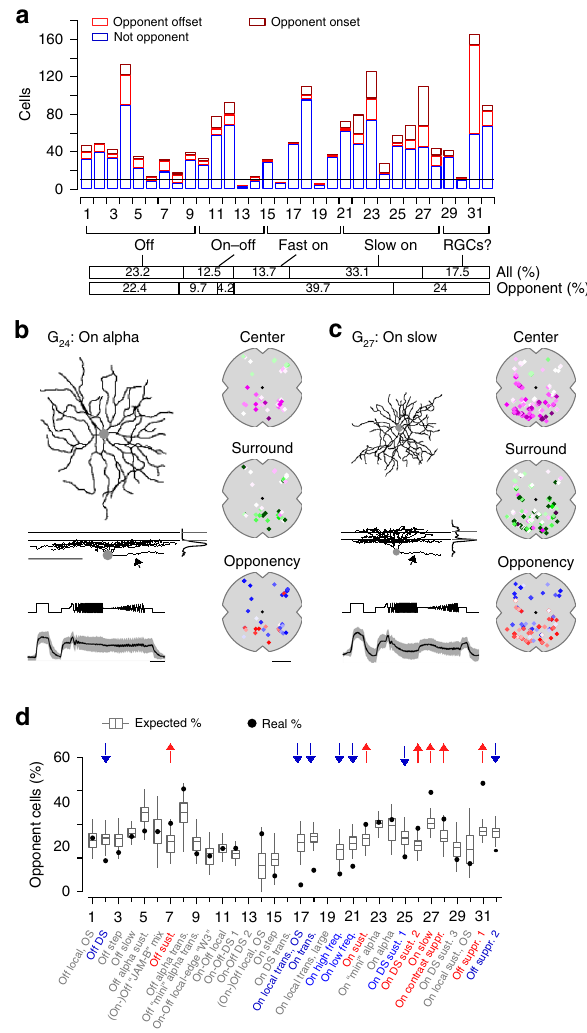
Fig. 7 The color-opponent output channels of the mouse retina. a Distribution of onset (dark red; ρ onset < -0.3 ) and offset (light red; ρ -0.3 ) color-opponent and non-opponent (blue) RGCs located in the offset < ventral retina. For analysis in d , onset and offset color-opponent cells were summed and only groups with n > 10 cells were used. Bars in the bottom illustrate the frequency (in percent) of different functional RGC classes (Off, On-Off, Fast On, Slow On and Uncertain RGCs; based on ref. 37 ), considering all RGCs (black) and color-opponent RGCs (onset and offset), respectively, located in the ventral retina. b Dendritic morphology with strati fi cation pro fi le of an exemplary RGC assigned to group G 24 , dye- fi lled and reconstructed subsequent to imaging experiments. Lines for side-view of morphology and strati fi cation pro fi le indicate On and Off ChAT bands. Arrows point at axon present only for RGCs and not for dACs. Scale bar: 100 µ m. Bottom shows mean full- fi eld chirp response (black, s.d. shading in gray; n = 5 trials; scale bar: 3 s) of RGC group G 24 . Panels on the right show recording positions of all cells assigned to G 24 , color-coded according to center (top) and surround (middle) spectral contrast (SC) and full- fi eld opponency (bottom). Scale bar: 1 mm. c Like b , but for G 27 . d Box plots (quartile method: Turkey; whisker method: s.d.) show distribution of expected percentages of color-opponent cells given center SC and SC Diff values in each group (for details, see Methods). Black circles indicate true percentage of color-opponent cells. Arrows pointing down- and up indicate groups with signi fi cantly more and less color-opponent cells than expected, respectively, (for cell numbers per group, see a ). G 1 :0.43, G 2 :0.006, G 3 :0.1, G 4 :0.27, G 5 :0.1, G 6 :0.44, G 7 :0.033, G 8 :0.052, G 9 :0.19, G 10 :0.46, G 11 :0.47, G 12 :0.14, G 13 :-, G 14 :0.053, G 15 :0.1, G 16 :-, G 17 :0, G 18 :0, G 19 :-, G 20 :0.019,